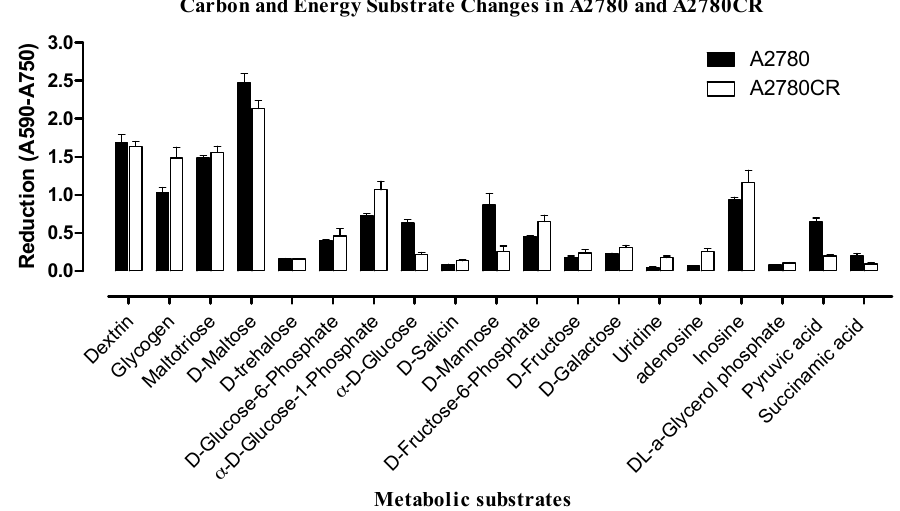
Figure 2. Comparison of substrate metabolism in A2780 and A2780CR. Dye reduction rates calculated following 24 h incubation of